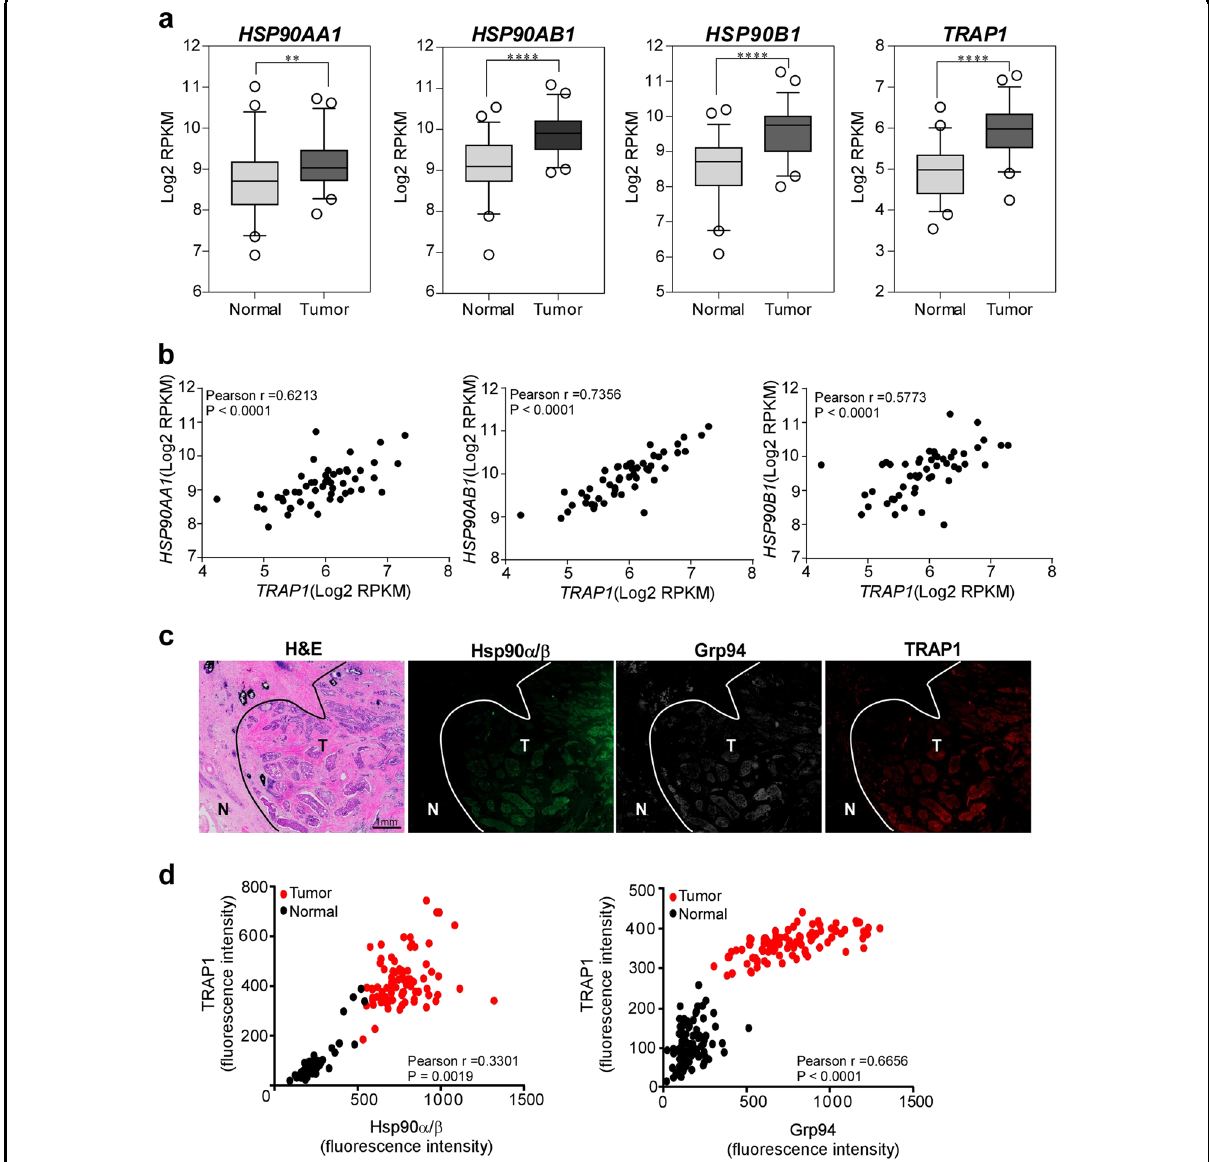
Fig. 1 Hsp90 paralogs are coexpressed in prostate tumors. a Expression of mRNA encoding Hsp90 gene family members obtained from TCGA RNAseq data. Expression of mRNA encoding HSP90AA1, HSP90AB1 (Hsp90 α / β ), HSP90B1 (Grp94), and TRAP1 (TRAP1) in cancer and normal tissues from 52 patients with prostate cancer; ** p < 0.005, **** p < 0.0001. b Correlation between HSP90AA1 and TRAP1 (left), HSP90AB1 and TRAP1 (middle), and HSP90B1 and TRAP1 (right) expression in the TCGA RNAseq database. c Expression of Hsp90 paralogs in human prostate cancer specimens. The boundary between the normal (N) and tumor (T) regions is indicated. Tumor specimens were analyzed by immuno fl uorescence staining with anti- TRAP1, anti-Hsp90, and anti-Grp94 antibodies, and protein expression in single cells was analyzed by confocal microscopy. Scale bar, 1 mm. d Expression of TRAP1 vs. Hsp90 (left) and TRAP1 vs. Grp94 (right). Tumor specimens were analyzed as in c . Data from 87 cells are presented in scatter plots. Pearson correlation coef fi cient ( r ) and p values are